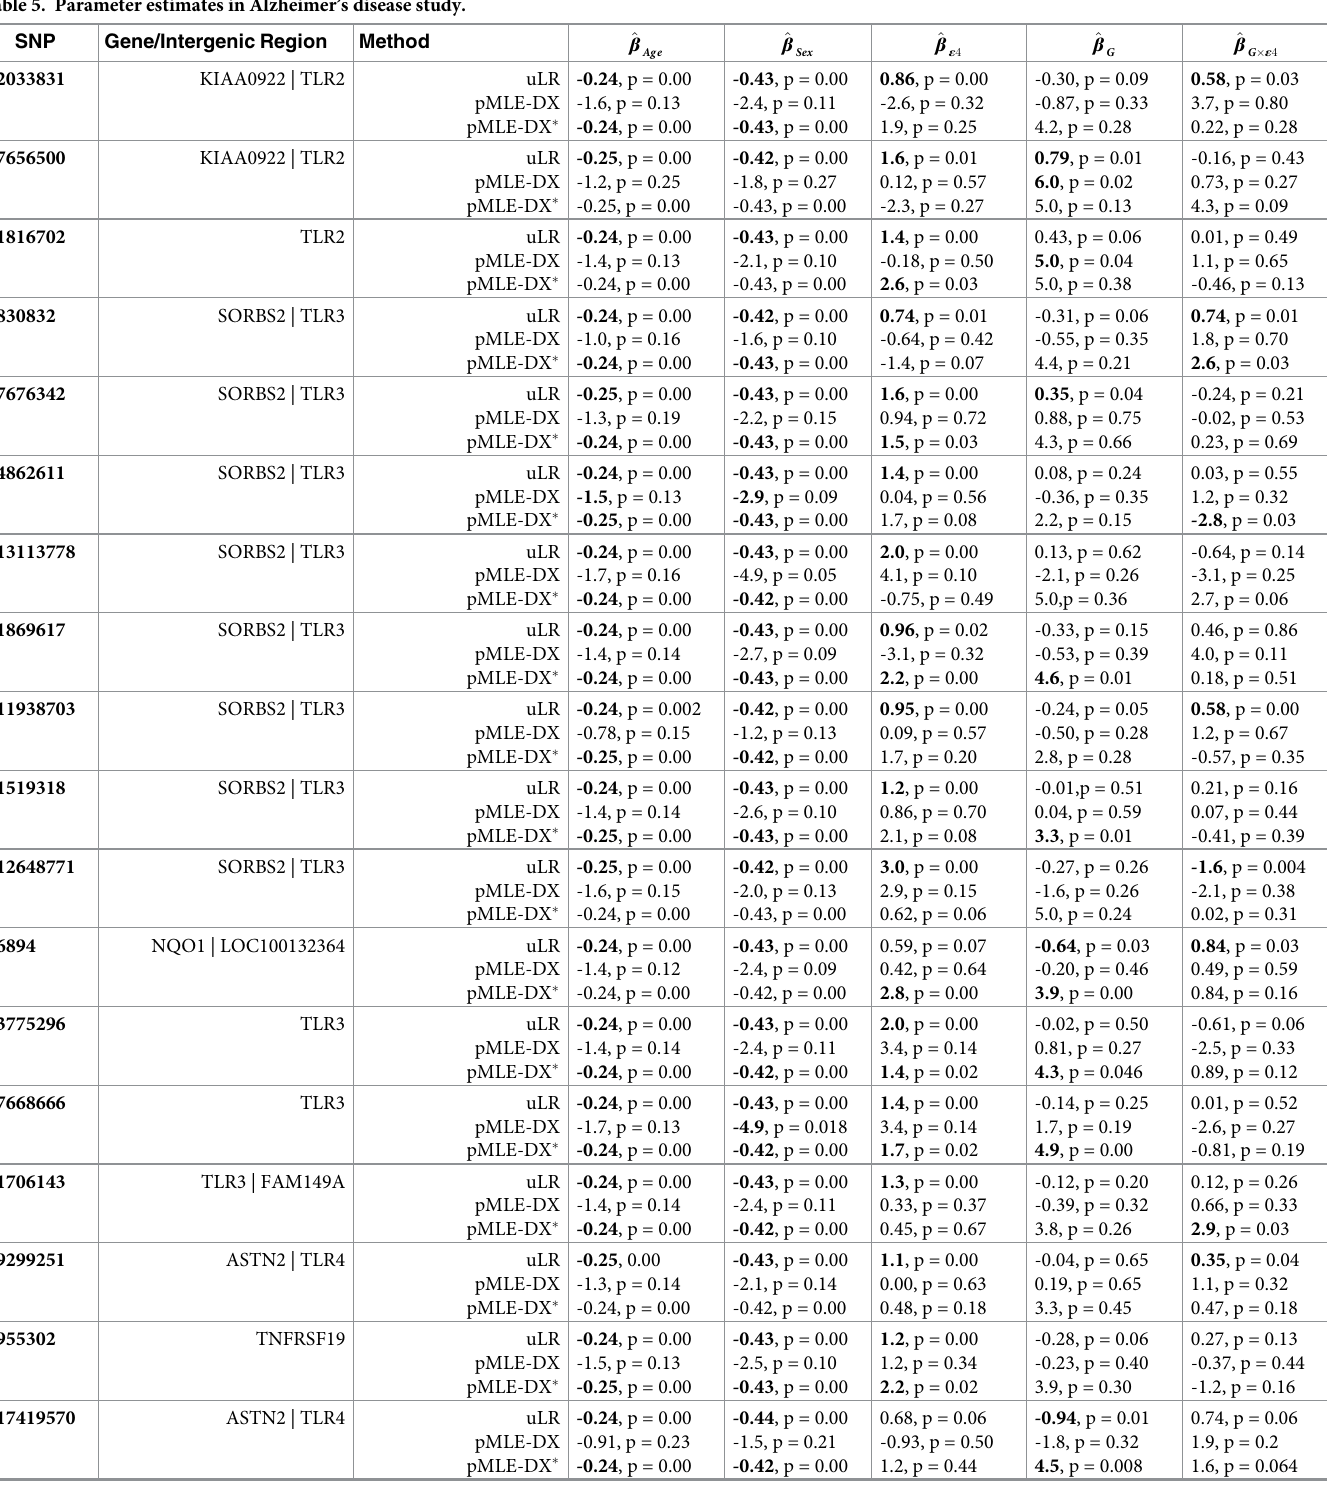
Table 5. Parameter estimates in Alzheimer’s disease